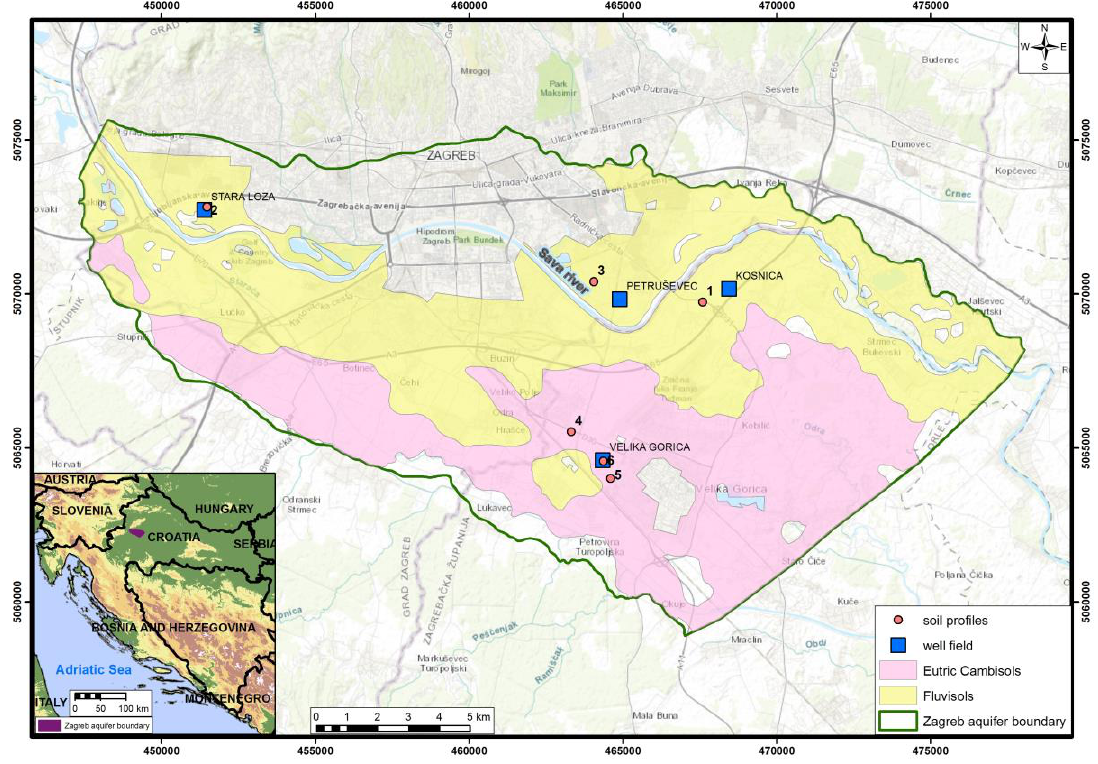
Figure 1. Zagreb aquifer with the study areas (soil profiles).